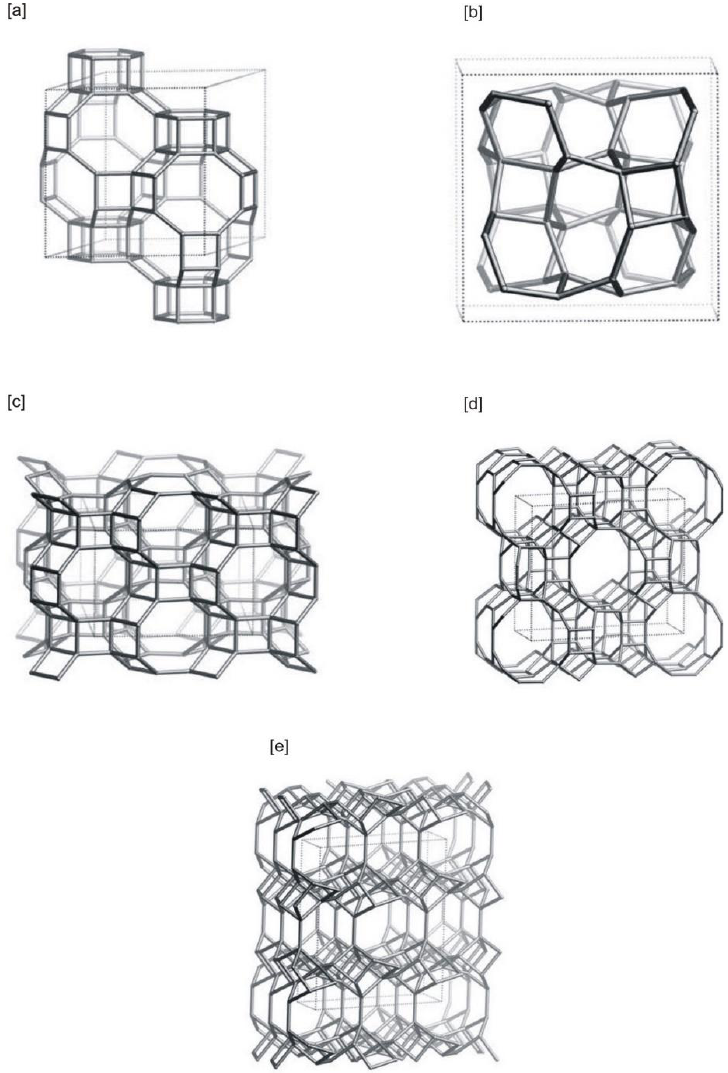
Figure 5. Structure of common natural zeolite frameworks viewed along [001]: ( a ) chabazite; ( b ) analcime; ( c ) phillipsite; ( d ) mordenite; and ( e ) clinoptilolite-heulandite. Modified from the Structure Commission of International Zeolite Association.